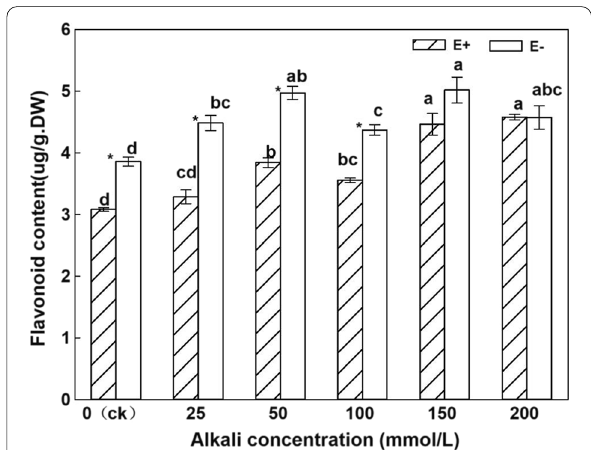
Fig. 2 Flavonoid contents in stems of E under different concentrations of alkali